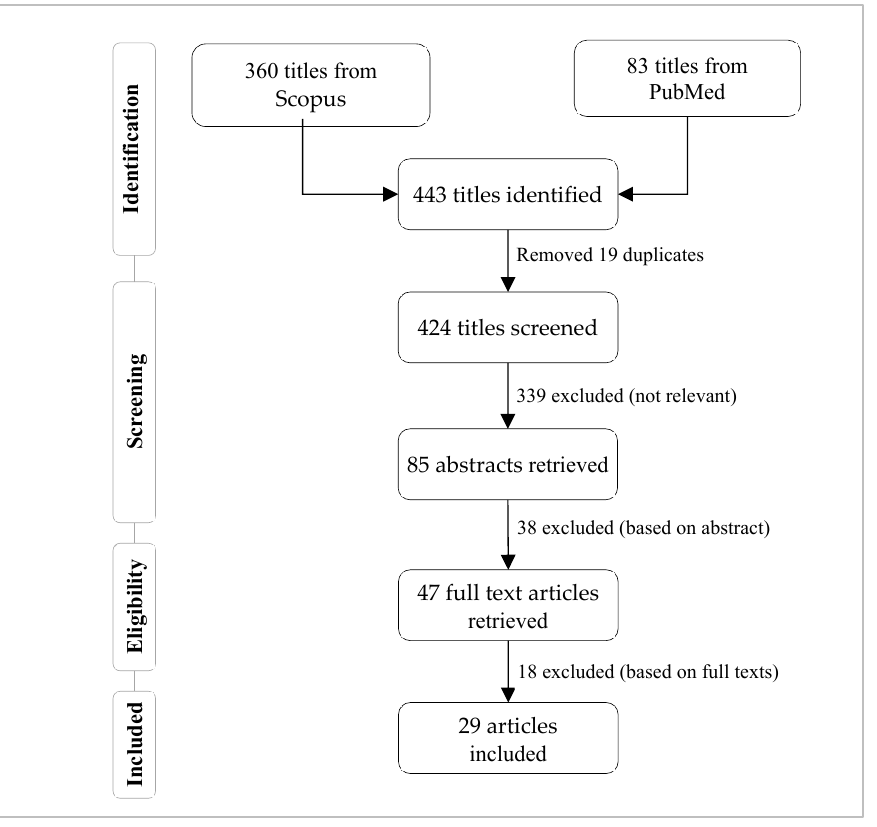
Figure 1. Flowchart for the selection of articles that were reviewed in this study.